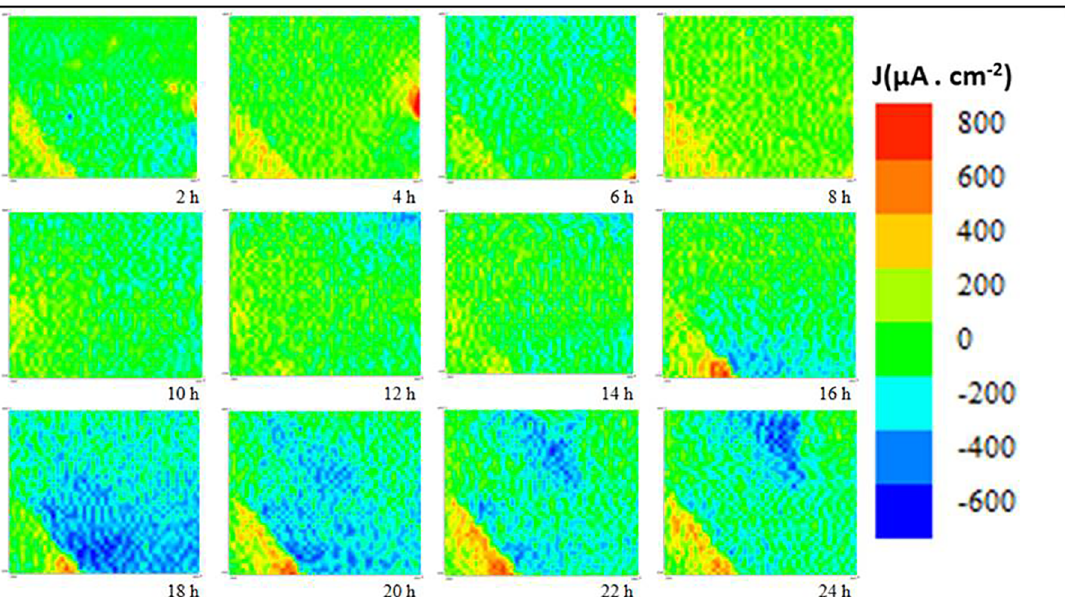
Figure 2. SVET maps showing the development of corrosion on the 22MnB5 steel electroplated with Zn-Ni along 24 h of immersion in 0.001 mol·L -1 NaCl